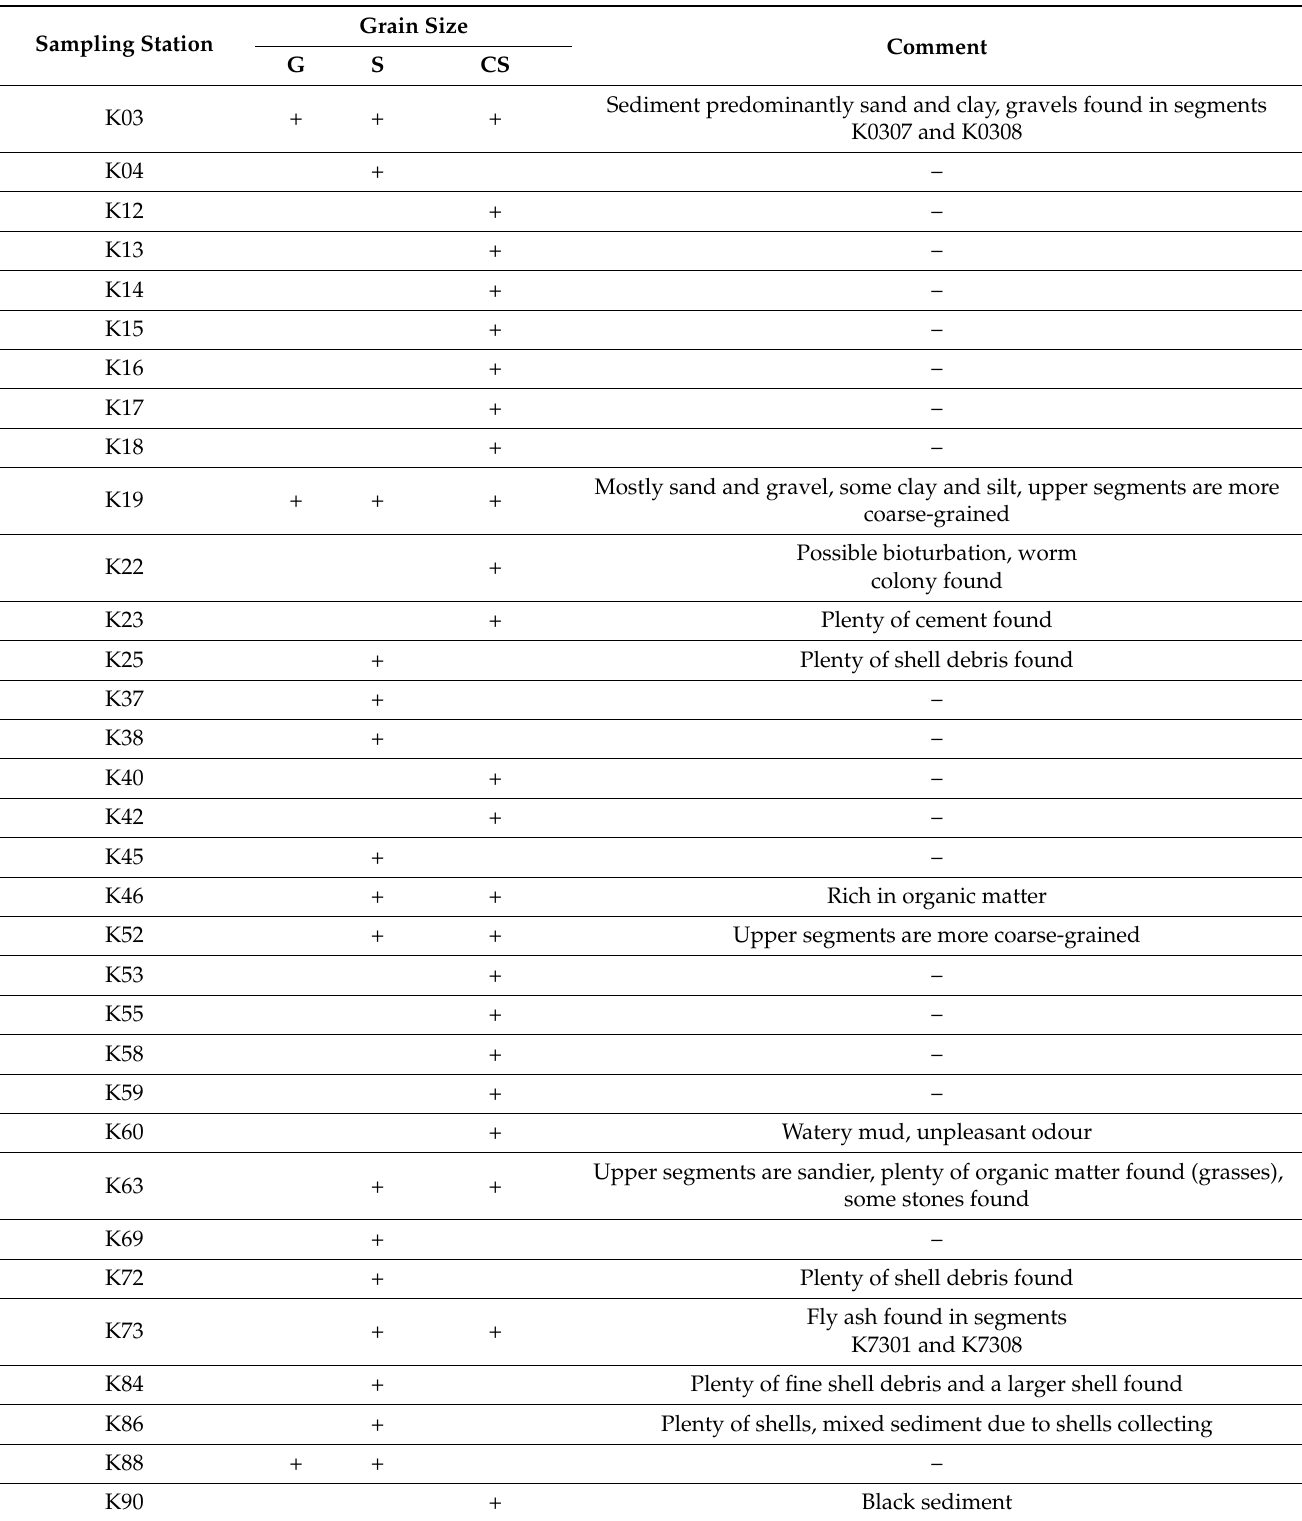
Table 4. Grain size composition of sediments visually determined on-site; +, presence of the specific grain size; G, gravel; S, sand; CS, clay and